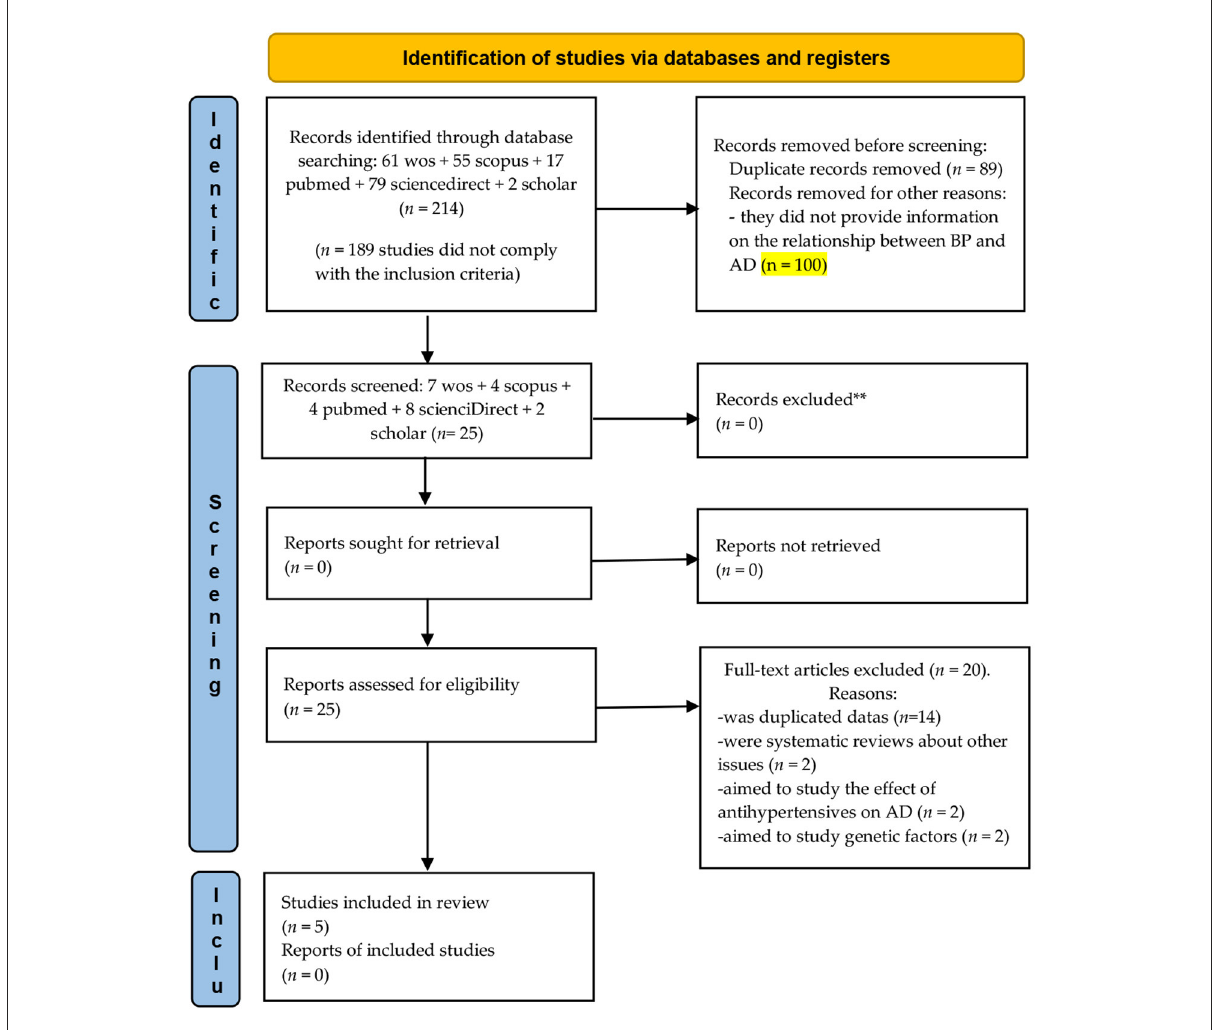
FIGURE1 Flowchart depicting the selection of articles for our meta-analysis. From Page et al. (56).